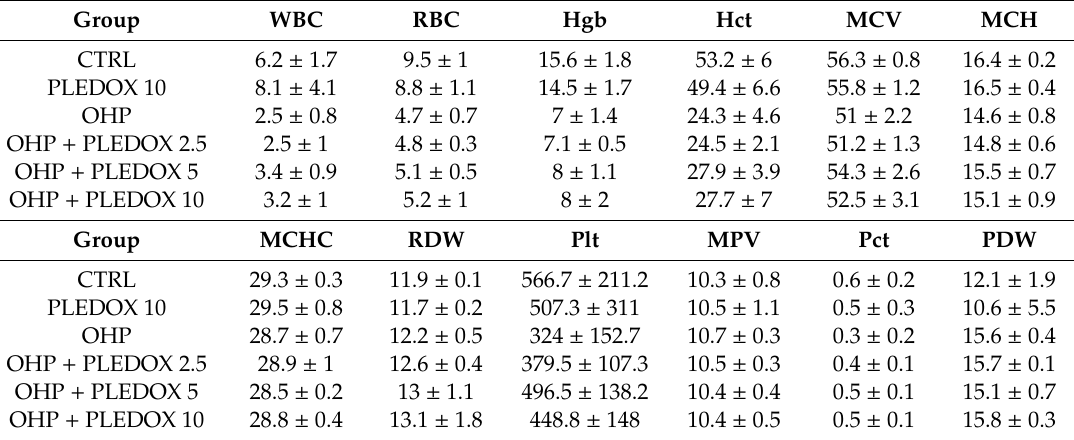
Table 1. Blood cell counts at the end of